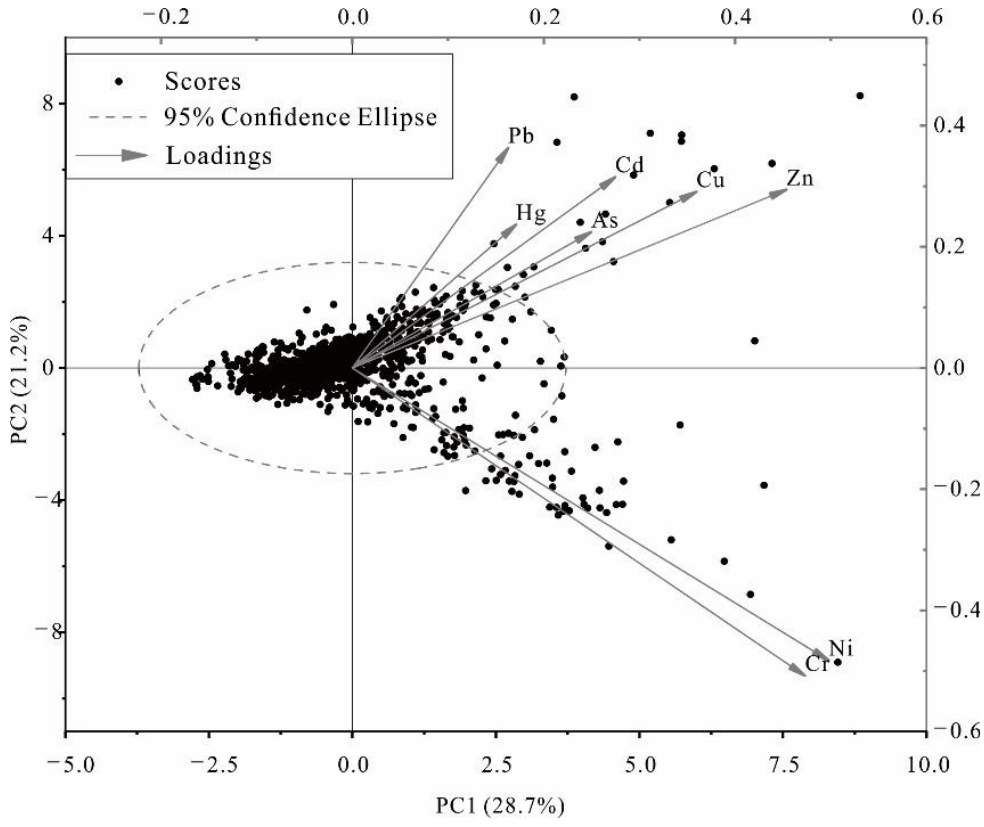
Figure 3. Principal component analysis plot of eight heavy metals in the study area.